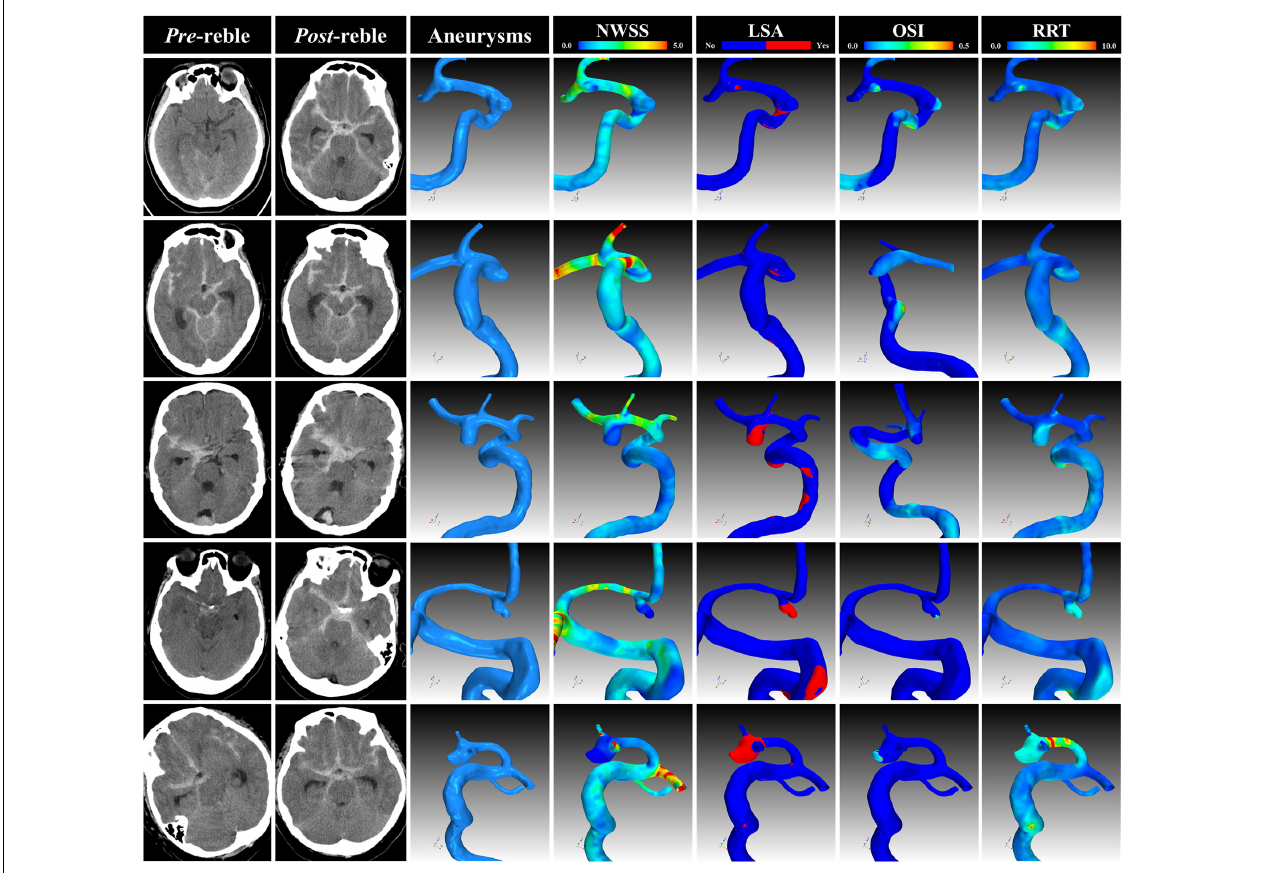
FIGURE 2 | Representative cases. The CT, angiogram and hemodynamic analysis of several representative cases. CT, computational tomography; NWSS, normalized wall shear stress; LSA, low shear area; OSI, oscillatory shear index; RRT, relative resident